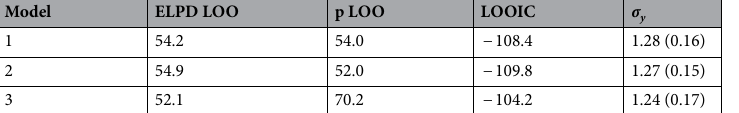
Table 2. Model criteria statistics including posterior mean estimates obtained from the RStan analysis. LOO is abbreviation for leave-one-out cross-validation, LOOIC is the LOO information criterion, ELPD is the expected log pointwise predictive density for a new, simulated, dataset based on the inferred posteriors obtained from the RStan analysis, p is a simulation-estimated effective number of parameters. Standard errors are in parentheses. Higher values of elpd indicate a better predictive performance. The posterior standard deviations are shown in parentheses and σ y is the model residual standard